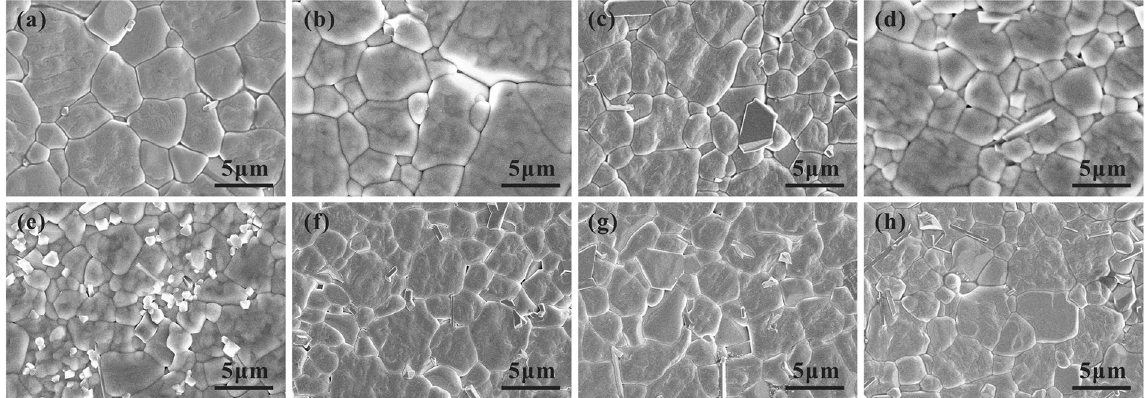
Figure 2. SEM micrographs on the polished and thermal-etched surfaces of the (1-x)LLBNTZ-xNBN ceramics: ( a ) x = 0, ( b ) x = 0.02, ( c ) x = 0.04, ( d ) x = 0.06, ( e ) x = 0.08, ( f ) x = 0.10, ( g ) x = 0.12, ( h ) x =